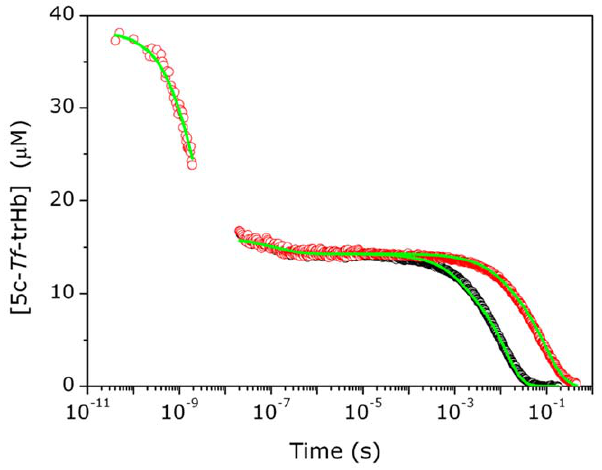
Figure 9. Fitting results. Results of global analysis of the complete course of CO binding kinetics to Tf -trHb merging ultrafast transient absorption and nanosecond laser flash photolysis data at T =20 u C and 1 (black) and 0.1 atm (red). The fits (green lines) are superimposed to the experimental data (circles).